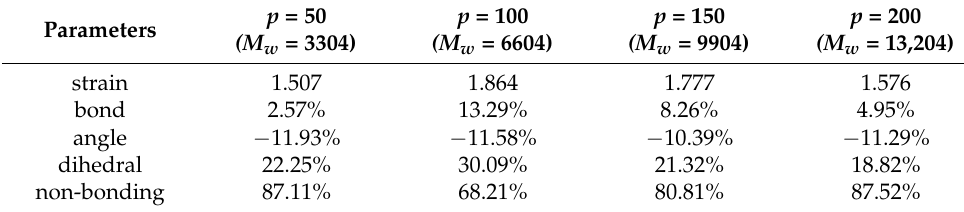
Table 2. The proportion of each energy component at the maximum of total system energy.